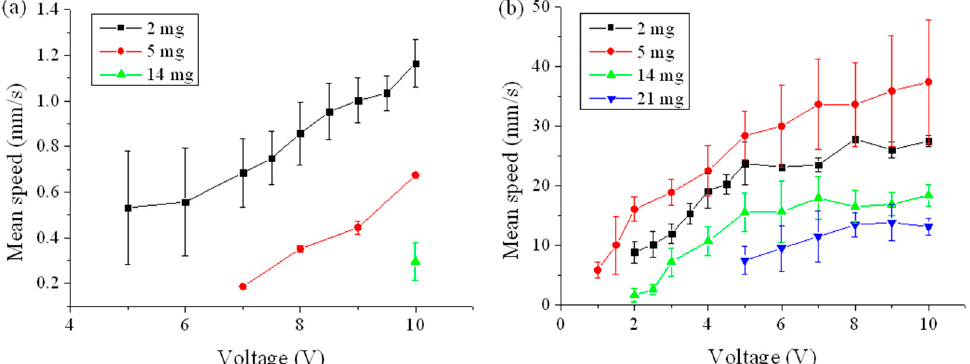
Figure 7. Kinetic characterization results of the linear motor with different sliders in ( a ) the travelling wave (TW) operation mode excited at 19.55 kHz with a phase difference of 90° and ( b ) the standing wave (SW) operation mode with the (5,0) mode excited at 24 kHz and a phase difference of 180.